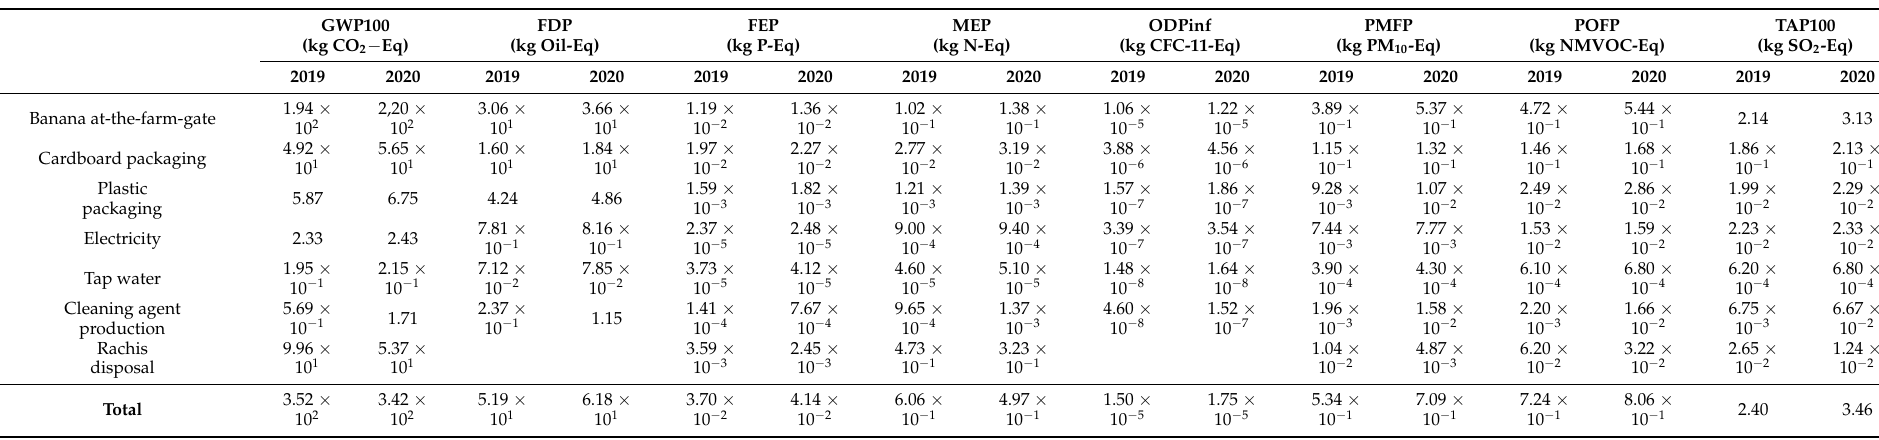
Table 4. Impact category indicator results for 1 ton of “Banana at-the-packaging-stage-gate” for years 2019 and